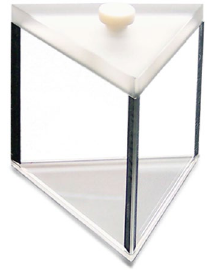
Figure 1. Hollow prism from 3B